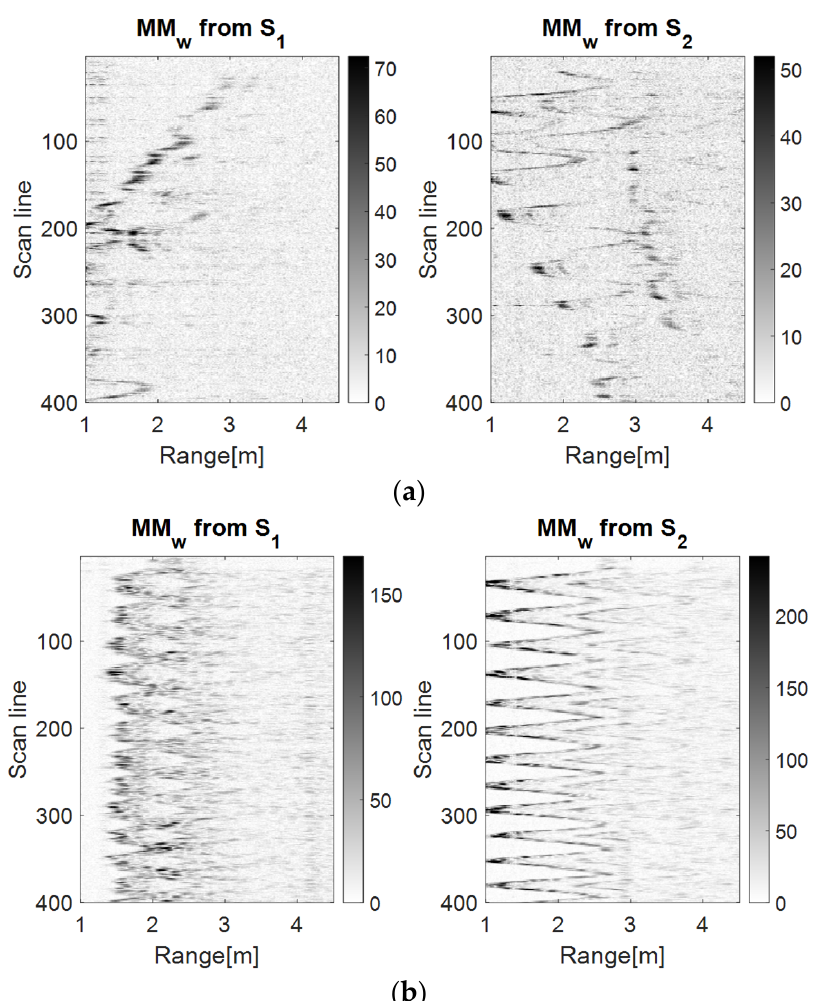
Figure 8. The drone ( a ) and the human ( b ) left–right movement maps using the wavelet analysis using the Morlet wavelet as the mother function.